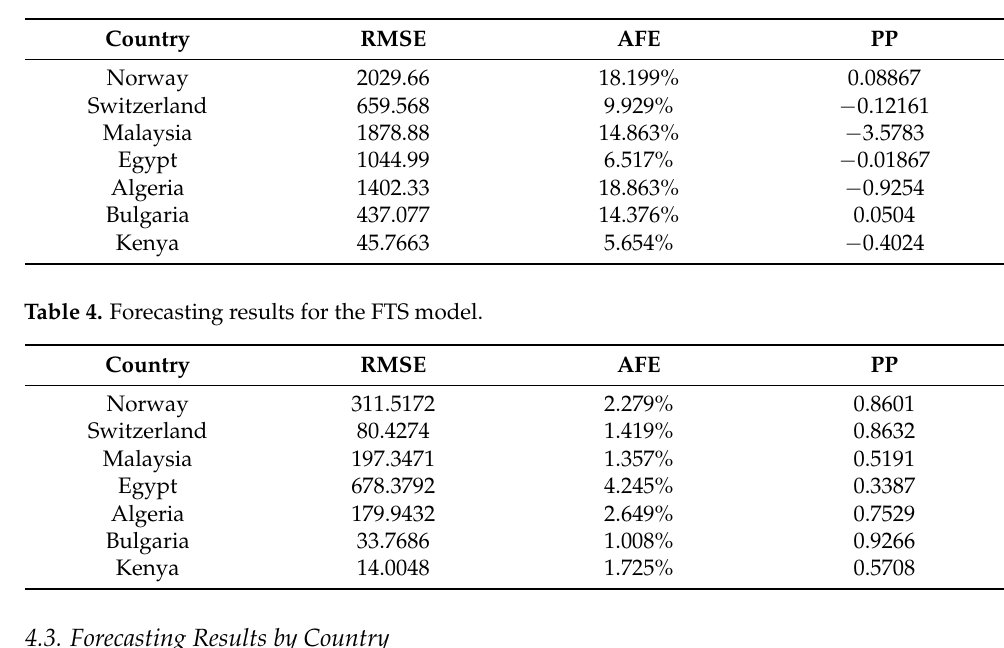
Table 3. Forecasting results for the LSSVM model.